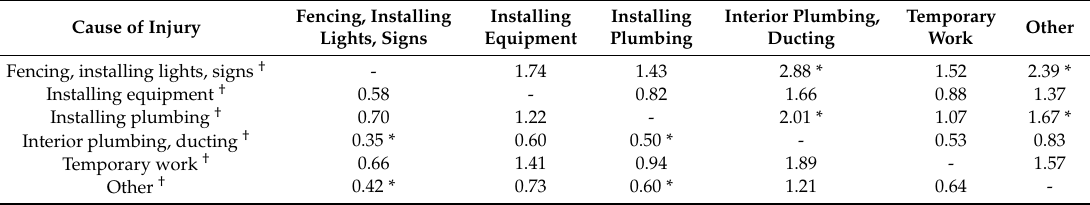
Table 10. Odds ratios of fatal accidents among di ff erent causes of injuries. Fencing, Installing Cause of Injury Lights,